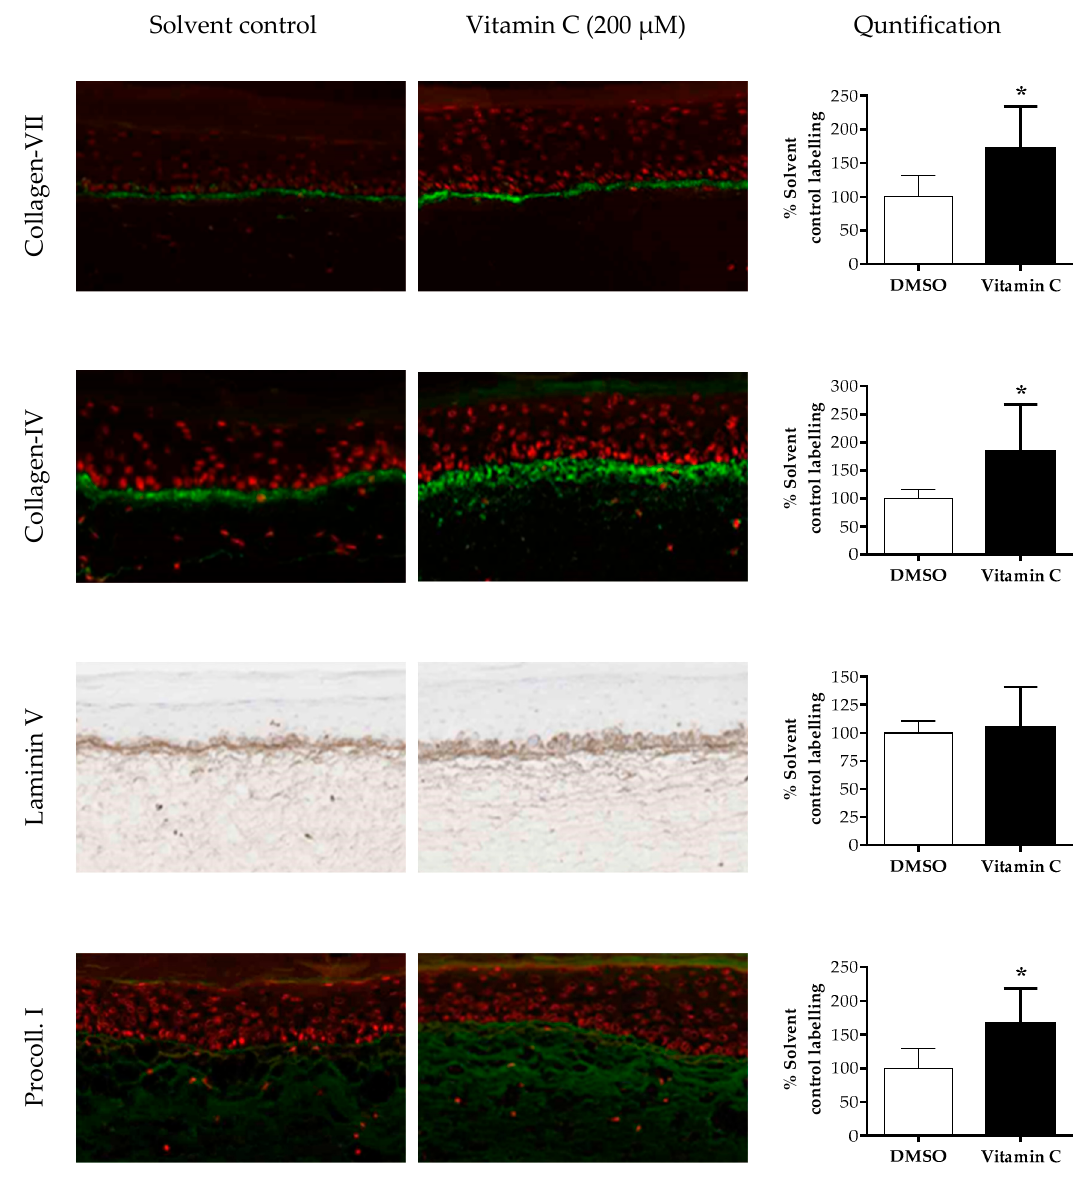
Figure 6. Effects of vitamin C on different biomarkers in the dermis and DEJ of T-Skin™. Models were treated with 200 µm vitamin C or 100% water for 5 days. The DEJ markers collagen IV, VII and laminin 5 were analyzed. The pro-collagen 1 marker was analyzed in the dermal compartment only. The intensity of the fluorescence or DAB staining of immunolabeled sections of T-Skin™ was assessed using a semi-quantitative scoring method. The quantified results are expressed as a percentage of control treated values, mean ± SEM; n = 3 T-Skin™ batches. A p value of < 0.05 was considered to be statistically significant, denoted by an asterisk.